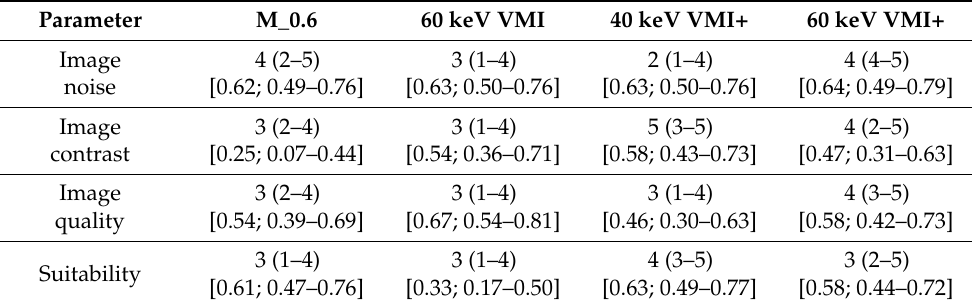
Table 3. Qualitative image analysis. The image parameters image noise, image contrast, image quality, and suitability were compared between linearly blended M_0.6, standard virtual monoen- ergetic imaging (VMI) at 60 keV, and noise-optimized VMI+ series at 40 keV and 60 keV levels.